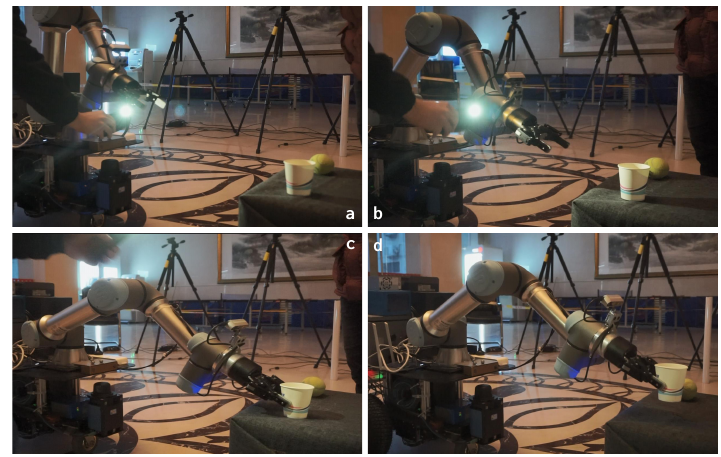
Figure 13. The process of grasping in a high-light environment. ( a ) Detecting the object. ( b ) Approaching the object. ( c ) Grasping the object. ( d ) Placing the